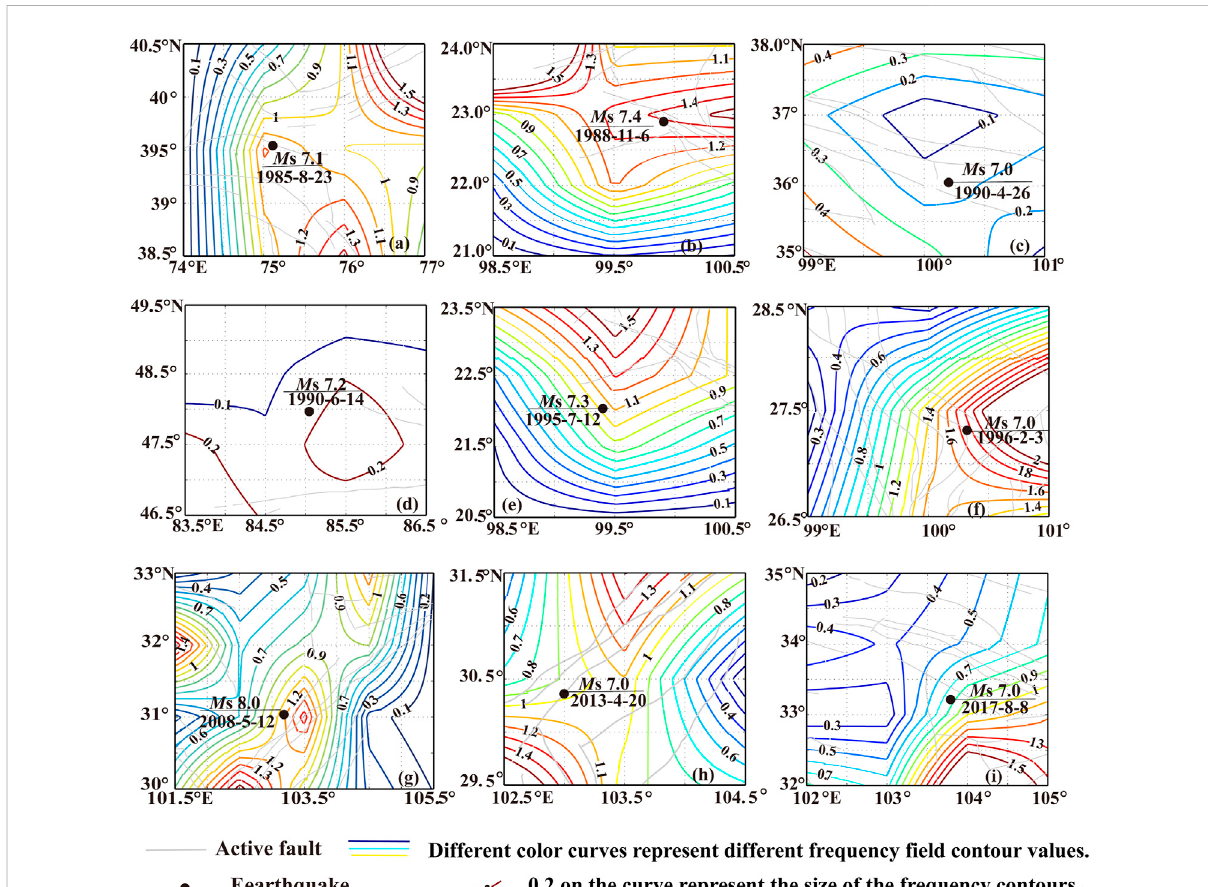
FIGURE 4 Frequency fi eldcontourmapsof9 M s ≥ 7.0earthquakesthatoccurredinmainlandChina,theblackdotsrepresentearthquakes,theblue,green, orange and red lines represent frequency fi eld contours, and the gray lines represent active faults. (A) 1985 M s 7.1 Wuxia earthquake; (B) 1988 M s 7.6 Lancang – Gengma earthquake; (C) 1990 Ms 7.0 Gonghe earthquake; (D) 1990 Ms 7.2 Jeminay earthquake; (E) 1995 Ms 7.3 Myanmar – China earthquake; (F) 1996 M s 7.0 Lijiang earthquake; (G) 2008 M s 8.0 Wenchuan earthquake; (H) 2013 M s 7.0 Lushan earthquake; (I) 2017 M s 7.0 Jiuzhaigou